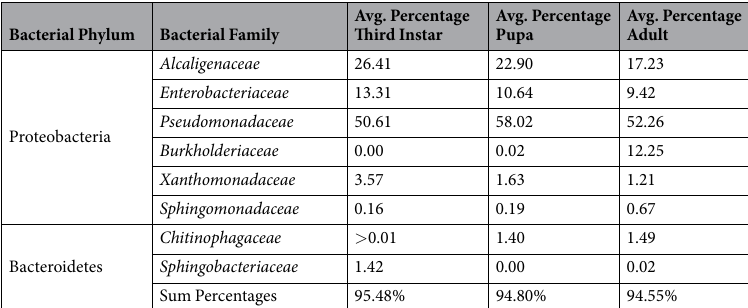
Table 2. Average percentage of bacterial families by insect